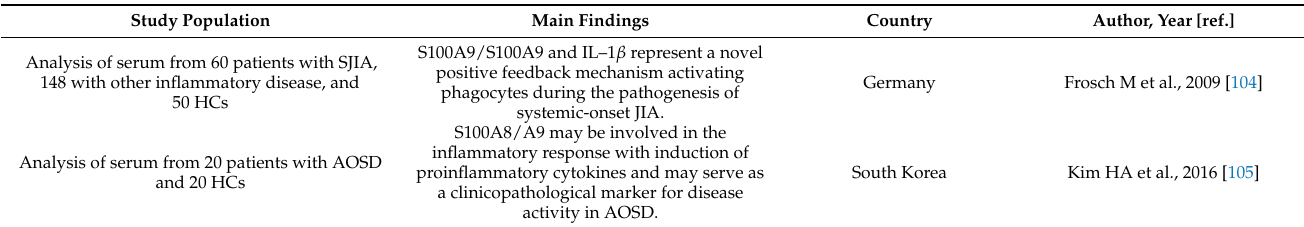
Table 2. List of studies indicating association between NETs and